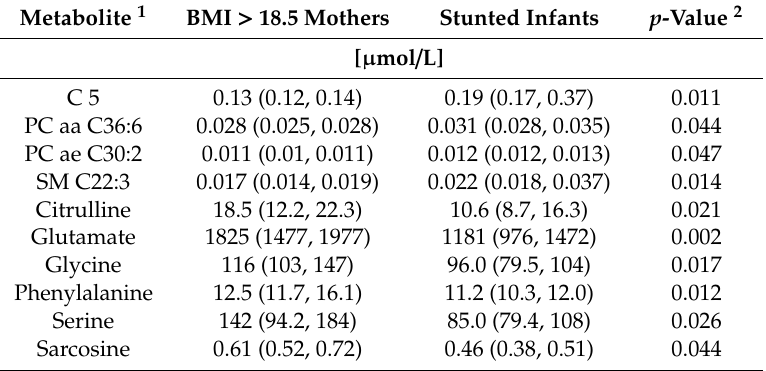
Table 2. Median concentrations and interquartile range (IQR) for milk metabolites affected by group (BMI > 18.5 mothers vs. stunted infants).